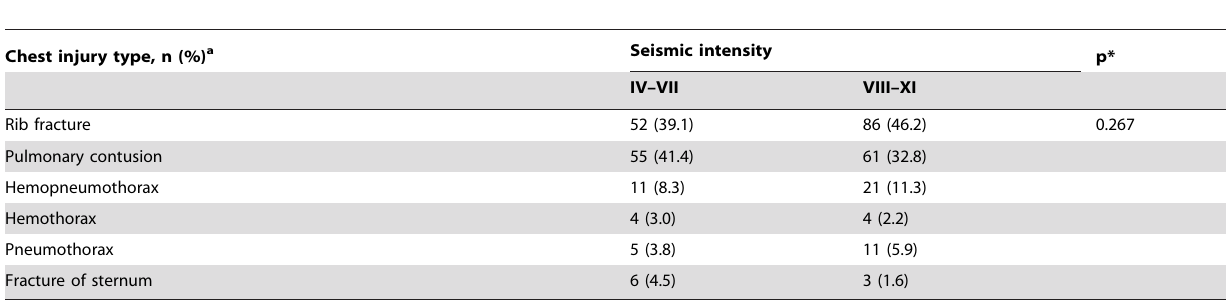
Table 5. Relationships between seismic intensity and the prevalence of types of chest injury in patients admitted to our hospital after the Wenchuan and Lushan earthquakes.